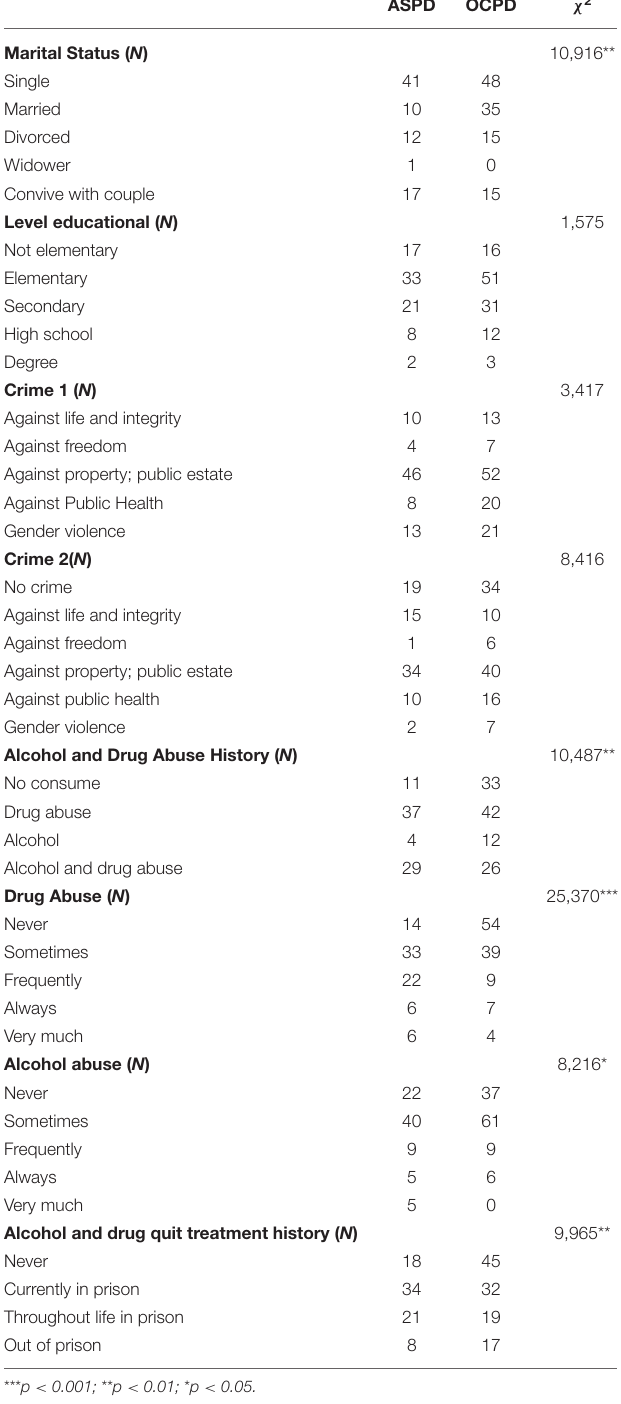
TABLE 1 | Sociodemographic variables and those related to drug abuse, alcoholism history, alcohol, and drug quit treatment and crimes between groups.